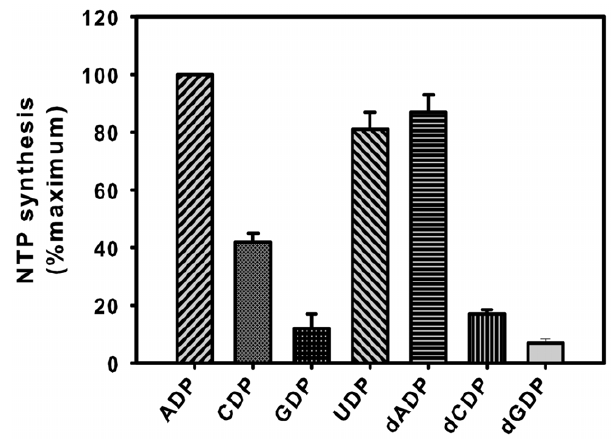
Figure 4. mPPK1 exhibits auxiliary NDK activity. NTP synthesiz- ing ability of mPPK1 was evaluated by incubating purified protein (5 m g) with 5 mM of NDP or dNDPs in a reaction mix containing poly- P20 as phosphate donor. Amount of different NTPs/dNTPs formed/min/ mg protein were calculated from standard curves as indicated under ‘Materials and Methods. The activity is expressed as % maximum (100%=197 6 14 m mol/min/mg of protein, n=3).